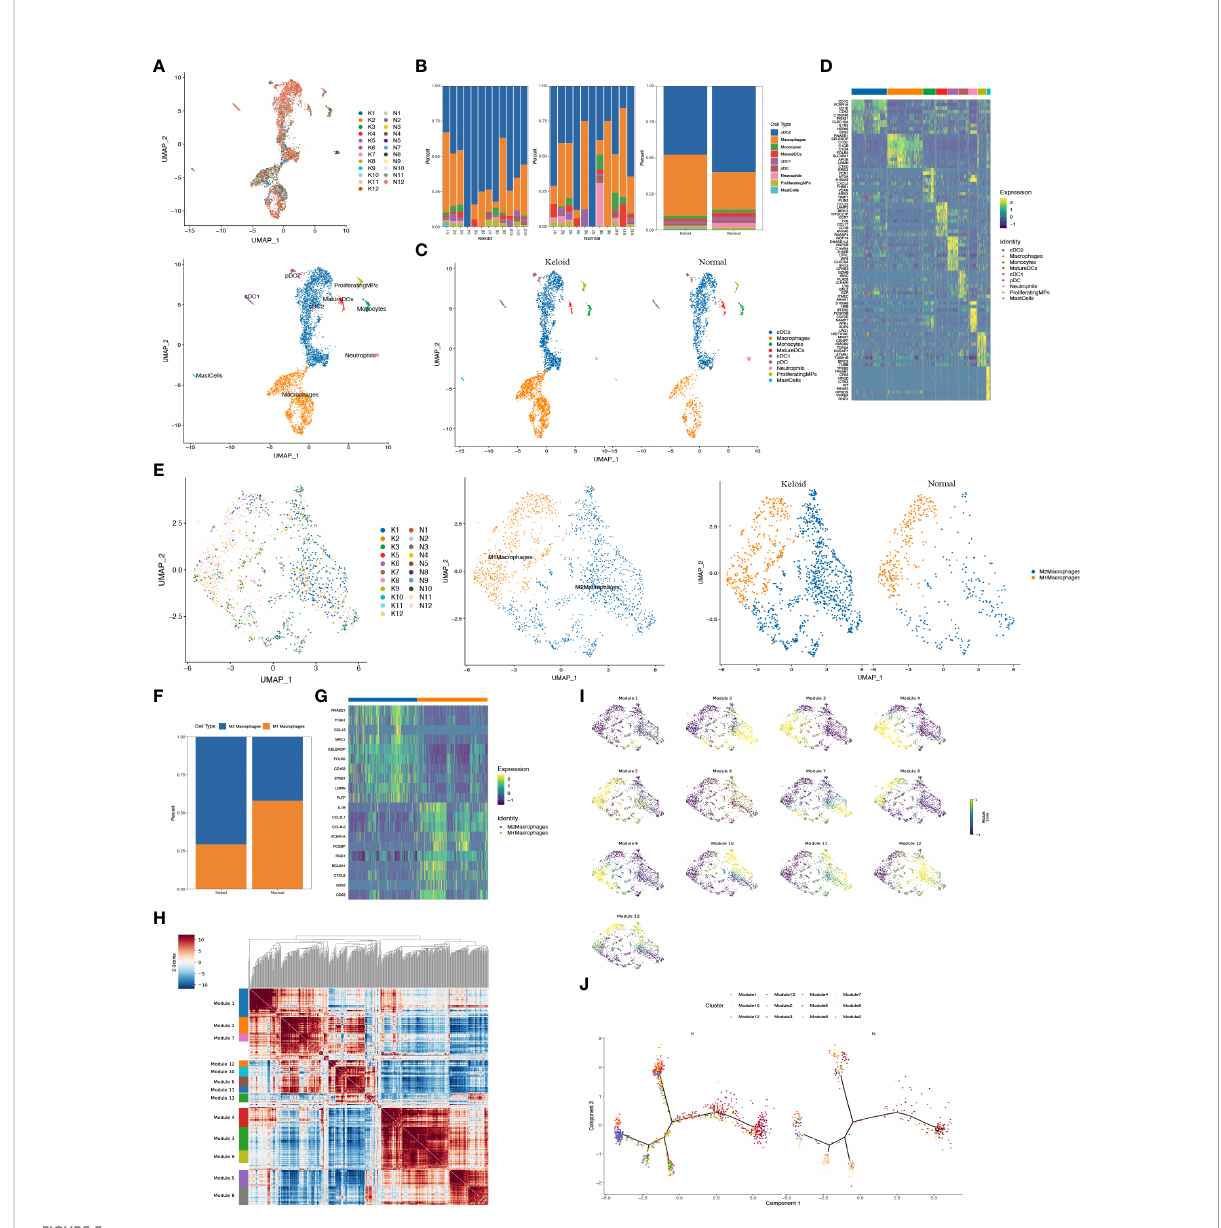
FIGURE 3 Characteristics of immunology pro fi le in human keloids. (A) Color-coded UMAP plot is shown, and each immune cell subpopulation is de fi ned as: macrophages, conventional type 1 dendritic cells (cDC1s), conventional type 2 dendritic cells (cDC2s), mature dendritic cells (MatureDCs), proliferating mononuclear phagocytes (ProliferatingMPs), plasmacytoid dendritic cells (pDCs), mast cells, neutrophils, and monocytes. (B, C) The proportions of immune cell subpopulations in keloid and adjacent normal tissue were shown. (D) Heatmap plots showing representative differentially expressed genes between the different types of immune cells in the keloids. (E, F) Demonstration of the ratio of M1 and M2 macrophage subpopulations in keloid and adjacent normal tissues. (G) Heatmap showing representative differentially expressed genes in M1 and M2 macrophage subpopulations. (H, I) Demonstration of representative modules of macrophages in keloid. (J) Pseudo-trajectory and cell source transition of macrophage cells between keloid and adjacent normal